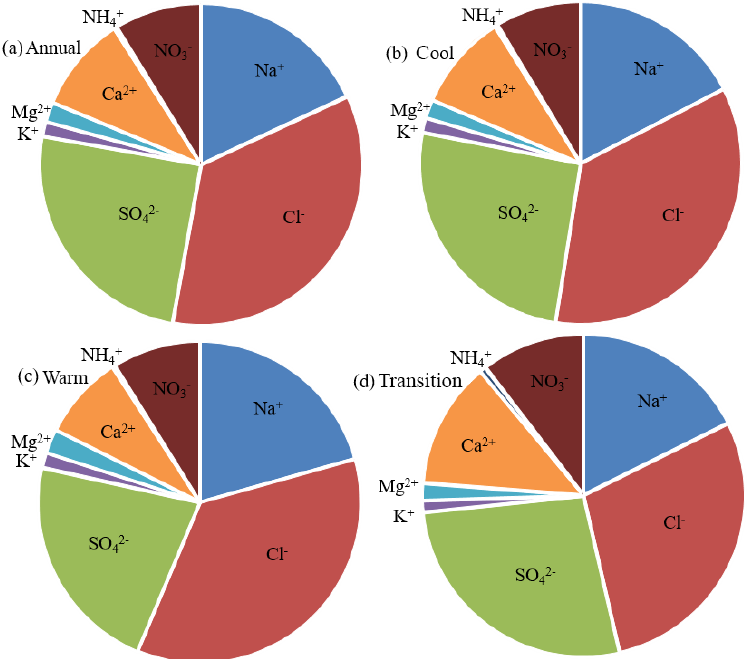
Figure 4. Mean contributions of each major ionic component to total ionic mass concentration of (a) Yongxing Island (YXI) annual, (b) YXI cool season, (c) YXI warm season and (d) YXI transition season. Table 1. Annual average, minimum and maximum mass concentrations (µgm − 3 ) of TSPs and aerosol chemical species at Yongxing Island.